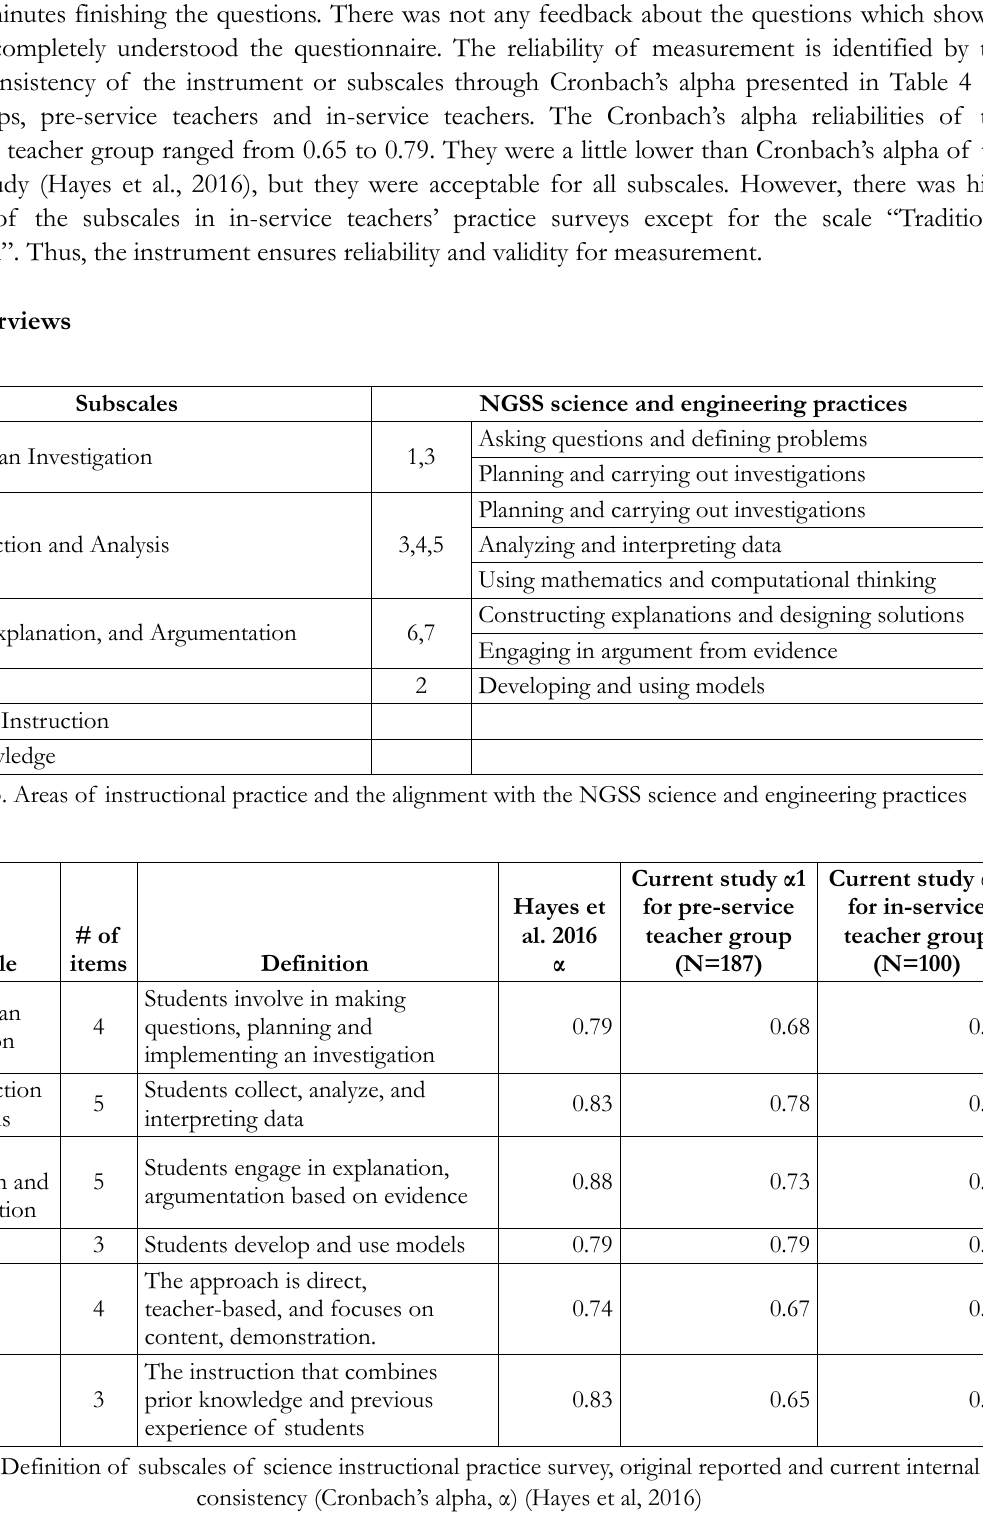
Table 4. Definition of subscales of science instructional practice survey, original reported and current